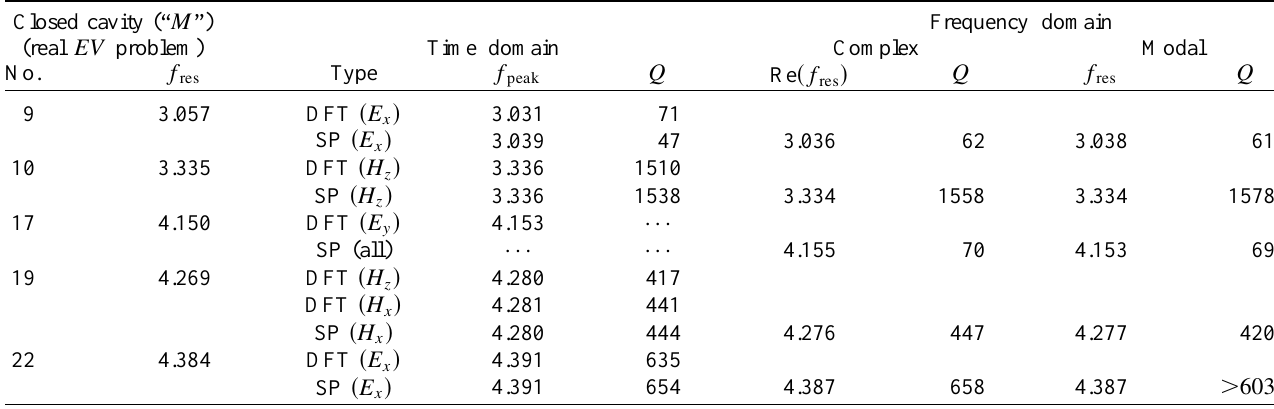
TABLE III. Some results of the computation of resonance frequencies (in GHz) and Q factors in the open single-cell test cavity. Time domain: The resonances are extracted from different time signals via graphical evaluation of the DFT or by signal processing techniques (SP). In some cases, no numerically stable results can be found due to too weak signals. Frequency domain: solution of a complex eigenvalue problem and modal approach. Closed cavity (“ M